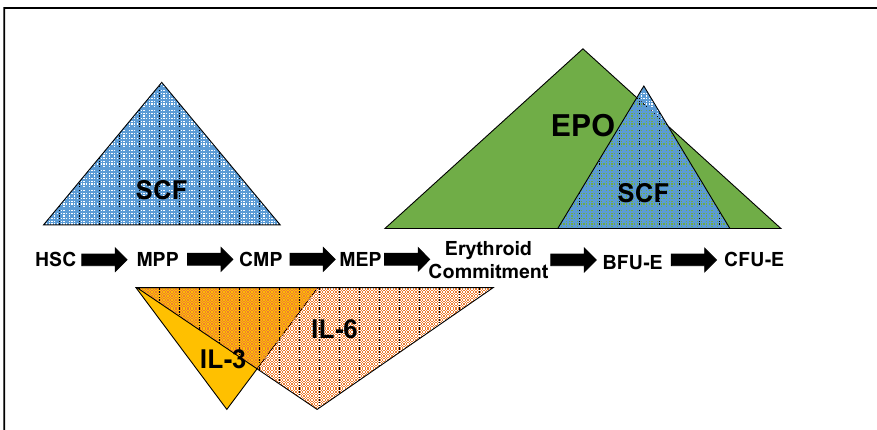
Figure 1. The cytokines Stem cell factor (SCF), Interleukin-3 (IL-3), Interleukin-6 (IL-6), and erythropoietin (EPO) impact erythroid progenitors at different stages of differentiation and can be synergistic, antagonistic or redundant, depending on the progenitor they are stimulating. HSC—hematopoietic stem cell. MPP—multipotent progenitor, CMP—common myeloid progenitor, MEP—megakaryocyte/erythroid progenitor, BFU-E—blast-forming unit-erythroid, CFU-E—colony-forming unit-erythroid.